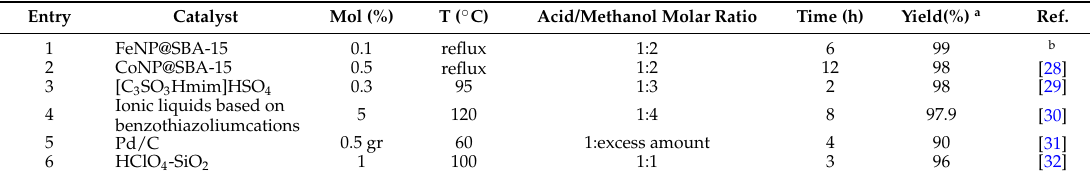
Table 3. Comparison of various systems in the esterification of benzoic acid by